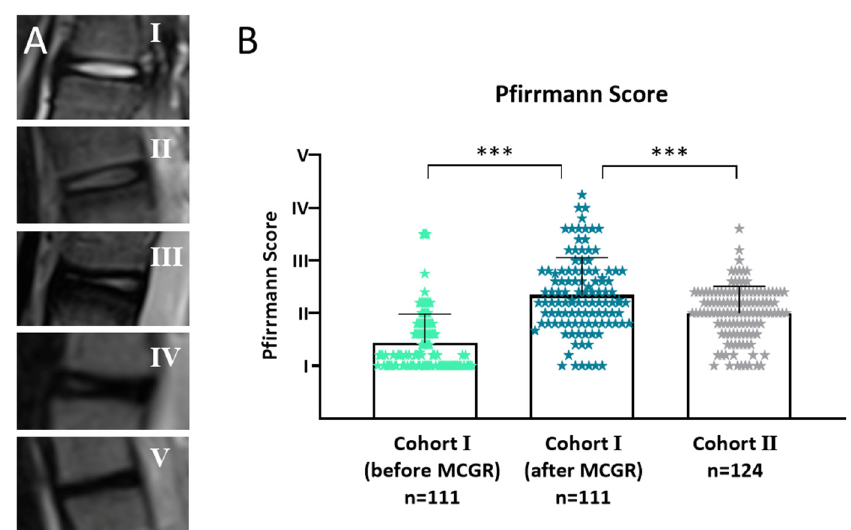
Figure 7. Intervertebral disc degeneration (IDD) measured with the Pfirrmann [13] score in 346 intervertebral discs. ( A ) Example images from the study population representing Pfirrmann scores I-V. ( B ) After an average of 5.1 years of MCGR treatment there was significantly more IDD in the same population. Age- and disease-matched patients without prior surgical treatment had significantly less IDD in comparison to pretreated individuals. Intervertebral discs were scored by five independent observers in a blinded manner and mean values from all observers are displayed. Cohort I (before MCGR) vs. Cohort I (after MCGR) Wilcoxon matched pairs test; Cohort I (after MCGR) vs. Cohort II Mann–Whitney test, n -numbers are given in the graph; included are n = 16/16/15 (T4/5), 14/14/15 (T7/8), 16/16/14 (T11/12), 13/13/16 (L1/2), 13/13/16 (L2/3), 13/13/16 (L3/4), 13/13/16 (L4/5), 13/13/16 (L5/S1), intervertebral discs from Cohort I (before MCGR), Cohort I (after MCGR) and Cohort II respectively; statistical level of significance p < 0.001 (***).